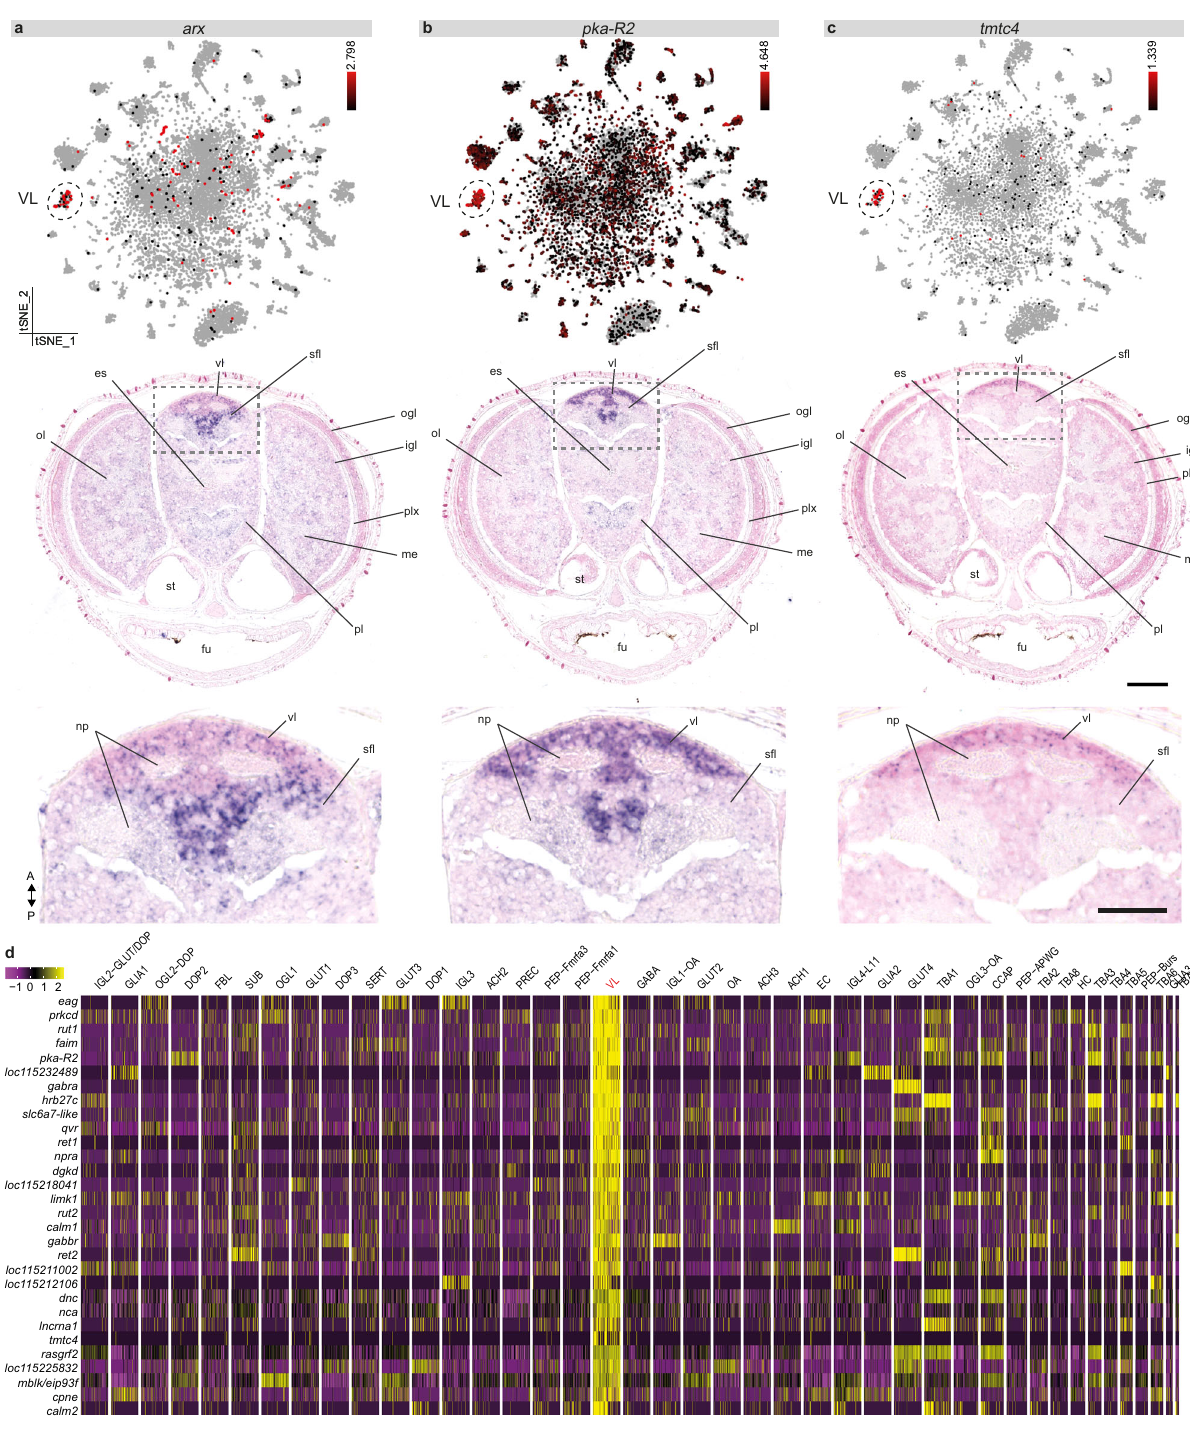
Fig. 5 | The molecular pro fi le of the vertical lobe cells. a Aristaless ( arx ) expression is limited to the vertical (vl) and the superior frontal lobe (s fl ). b cAMP- Dependent protein kinase regulatory subunit type II ( pka-R2 ) expression can be observed mostly in the vl and less within the s fl . c Transmembrane O-MannosyltransferaseTargeting Cadherins4( tmtc4 )isuniquelyexpressedwithin the most anteriorpart of the vl. t-SNE plots for arx , pka-R2 , and tmtc4 are shown in Fibroblast-like cells (FBL) were annotated based on their expres- sion of collagens, troponin, tropomyosins, and ribosomal genes. Octopus fi broblasts were organized in a layer that surrounds the brain (Supplementary Fig. 19). As this cell type produced an extracellular